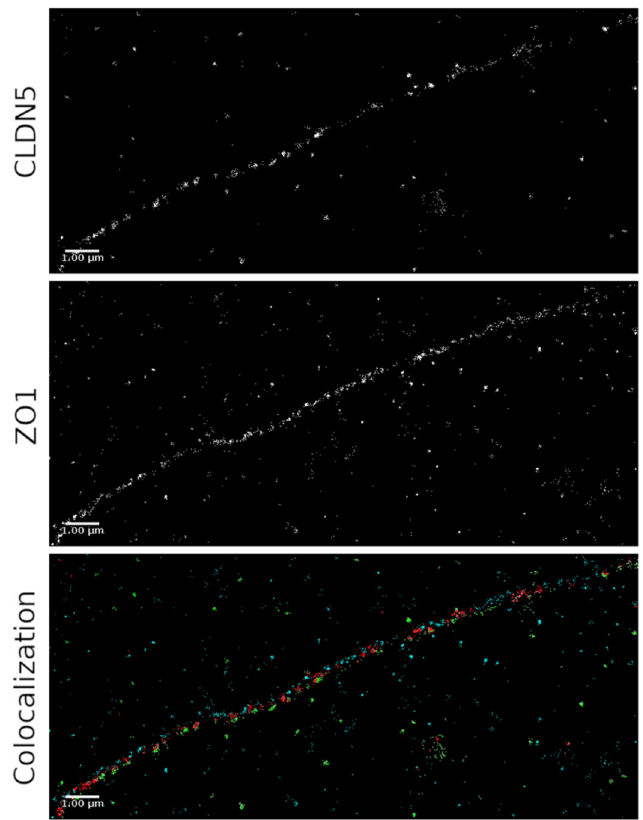
Figure 5. Colocalization analysis of ZO-1 and CLDN5 performed by SMLM. ZO-1 molecules are shown in blue, CLDN5 molecules in green, and co-localized molecules within 90 nm of each other are shown in red.